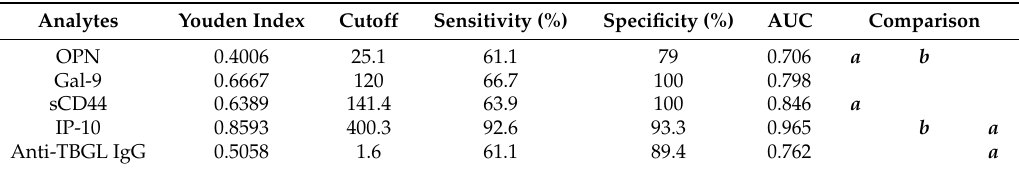
Table 4. Sensitivity and specificity.